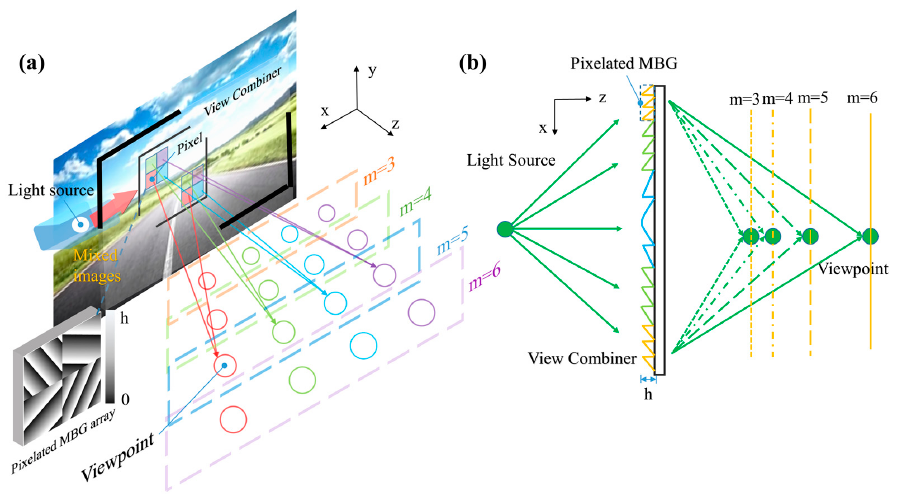
Figure 1. The schematic diagram of the AR vector light field display system. ( a ) Schematic of the AR 3D display based on a view combiner with pixelated MBG arrays. The 16-view forms a horizontal parallax along the x-direction. Pixelated MBG arrays with a height of h produce four sets of views along the propagation direction z for extended viewing distance; ( b ) Schematic diagram of the viewpoints formed by the pixelated MBG array in different focal planes (the third, fourth, fifth, and sixth-order diffractions are shown in the